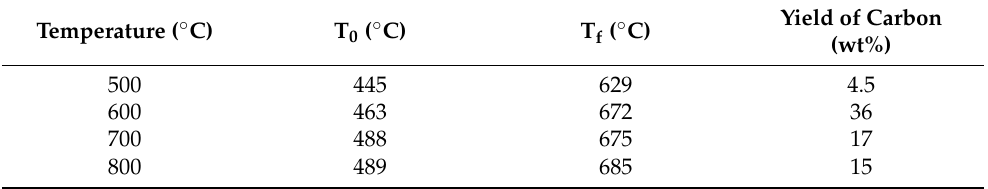
Table 4. The corresponding parameters of TGA of the SS@CNTs synthesized at various